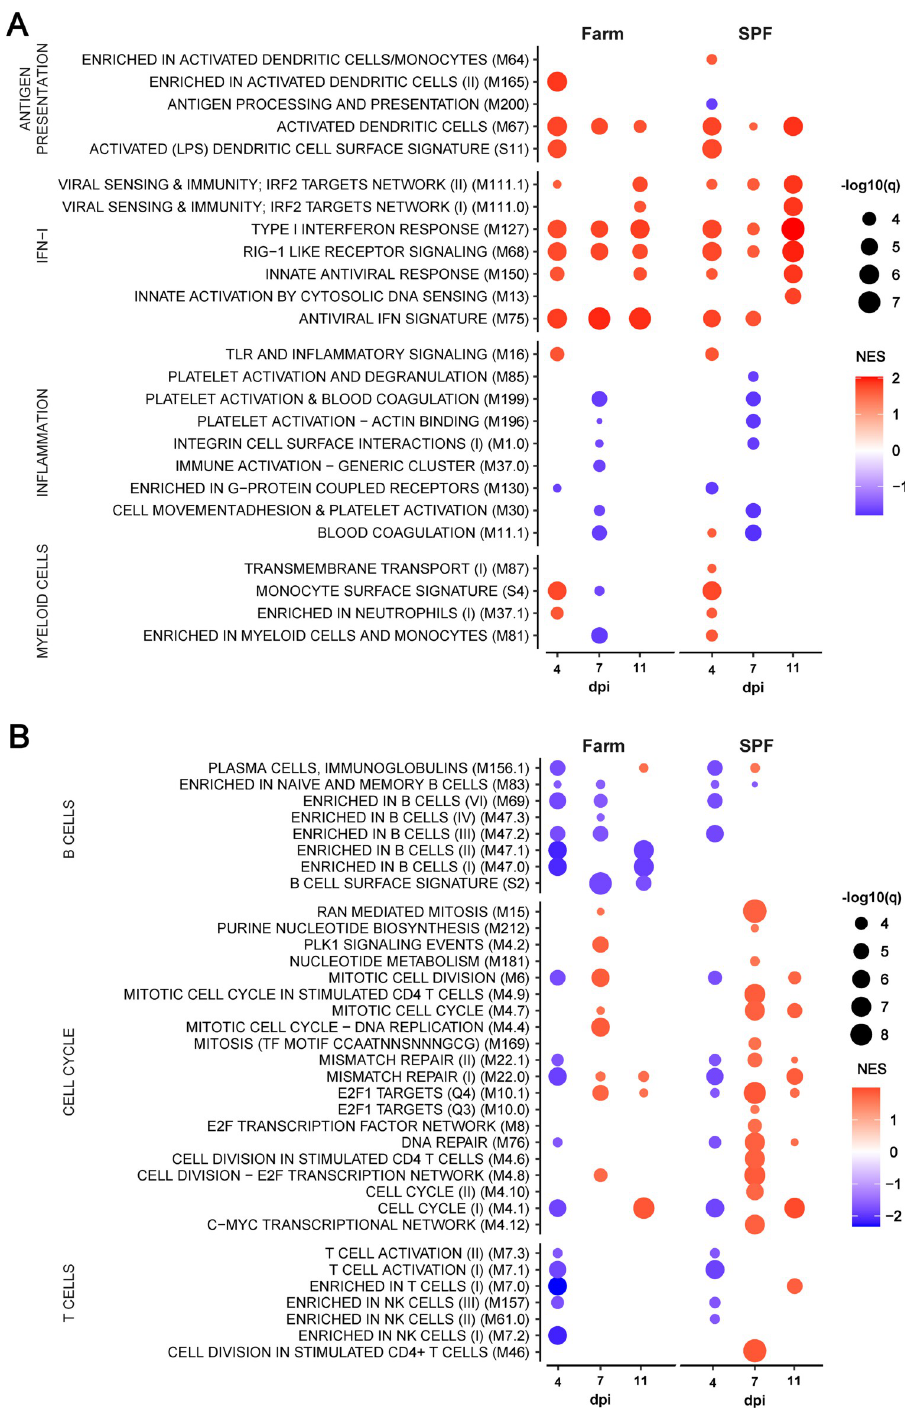
Fig 9. BTM analysis after infection with attenuated ASFV Estonia 2014. Data shows only the significantly different (A) innate and (B) adaptive immune cell BTMs in farm and SPF pigs at 4, 7 and 11 dpi relative to their respective BTM at baseline (day 0). BTM modulations were calculated as normalized enrichment scores (NES) using GSEA. Increased (red) or decreased (blue) BTMs are shown relative to each group’s respective baseline with color intensity proportional to the NES and the size of the data points proportional to the q value. Data is from n = 6/group.